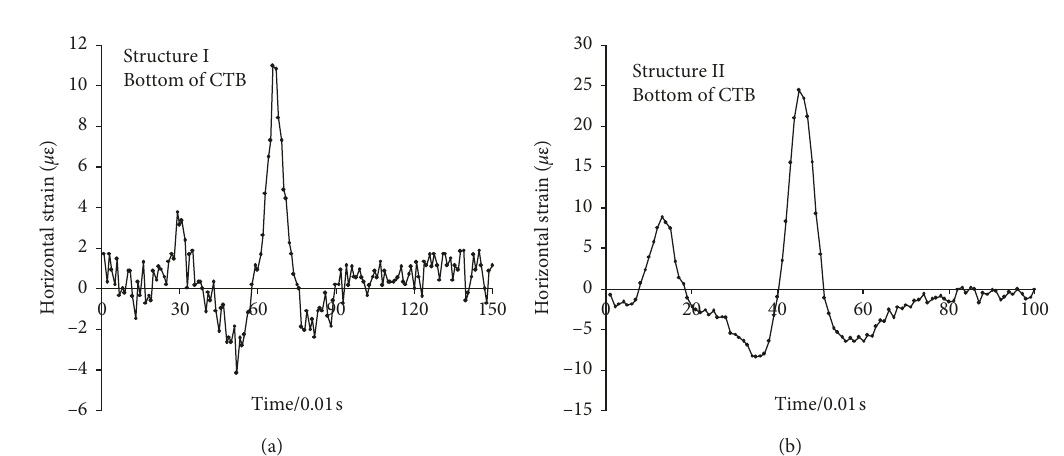
Figure 9: Horizontal strain at the bottom of AC-25F.